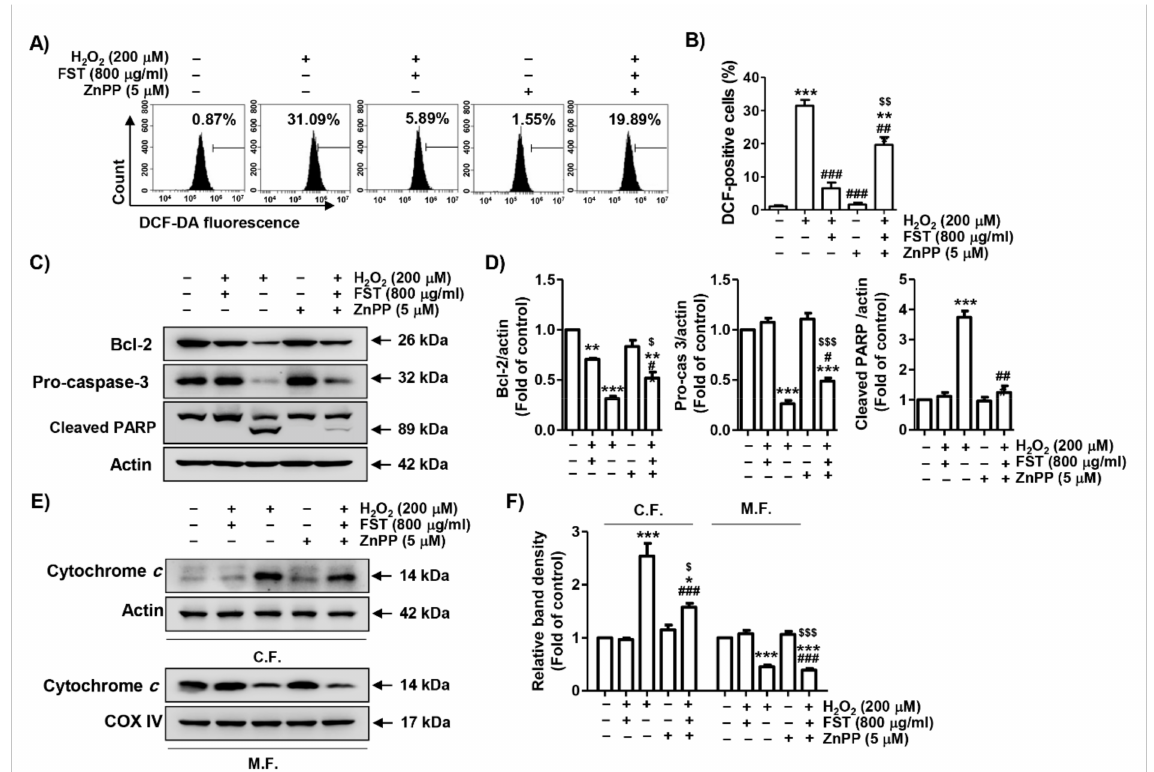
Figure 6. Effect of zinc protoporphyrin IX (ZnPP) on FST-mediated attenuation of MC3T3-E1 cells against H 2 O 2 -induced ROS production and changes in expression of apoptosis regulators. Cells were pretreated with the HO-1 antagonist ZnPP (5 µ M) with or without FST (800 µ g/mL) for 1h, and then subjected to treatment with H 2 O 2 (200 µ M) for 1 h ( A , B ) or 24h ( C , D ). ( A ) Intracellular ROS levels were determined using DCF-DA dye. ( B ) Ratios of DCF-positive cells were statistically quantified ( C ) The expression of apoptosis regulators. Actin was used to loading control. ( E ) Expression of cytochrome c in mitochondrial and cytoplasmic fractions. COX IV and actin were analyzed as internal controls for mitochondrial and cytosolic fractions, respectively. ( D , F ) Relative band density. ( B , D , F ) * p < 0.05, ** p < 0.01 and *** p < 0.001, and *** p < 0.001 vs. control cells. # p < 0.05, ## p < 0.01 and ### p < 0.001 vs. H 2 O 2 -treated cells. $ p < 0.05, $$ p < 0.01 and $$$ p < 0.001 vs. H 2 O 2 and FST-treated cells.